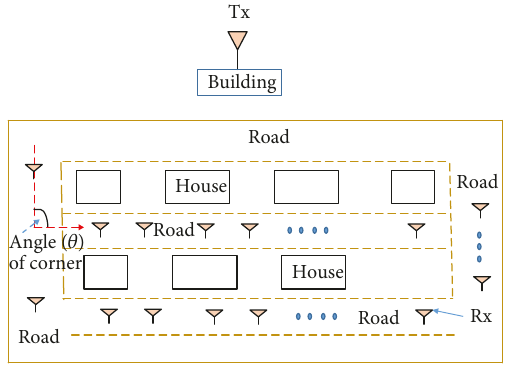
Figure 3: Top view of the house and road